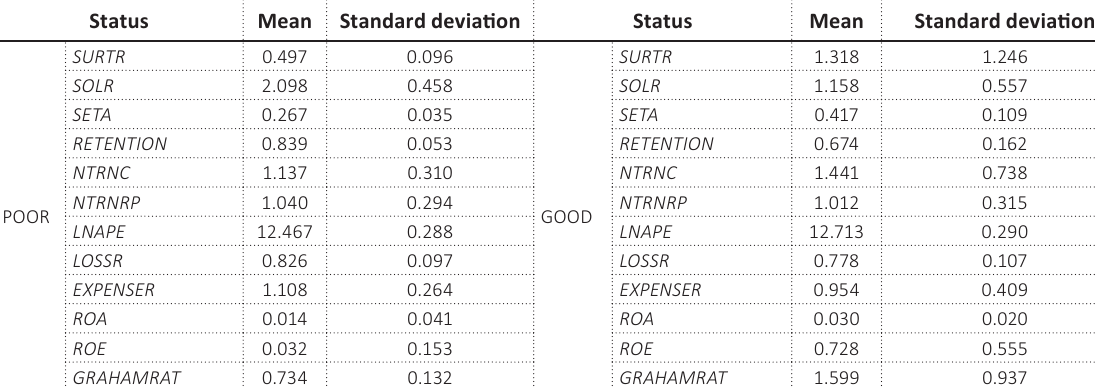
Table 1. Descriptive statistics